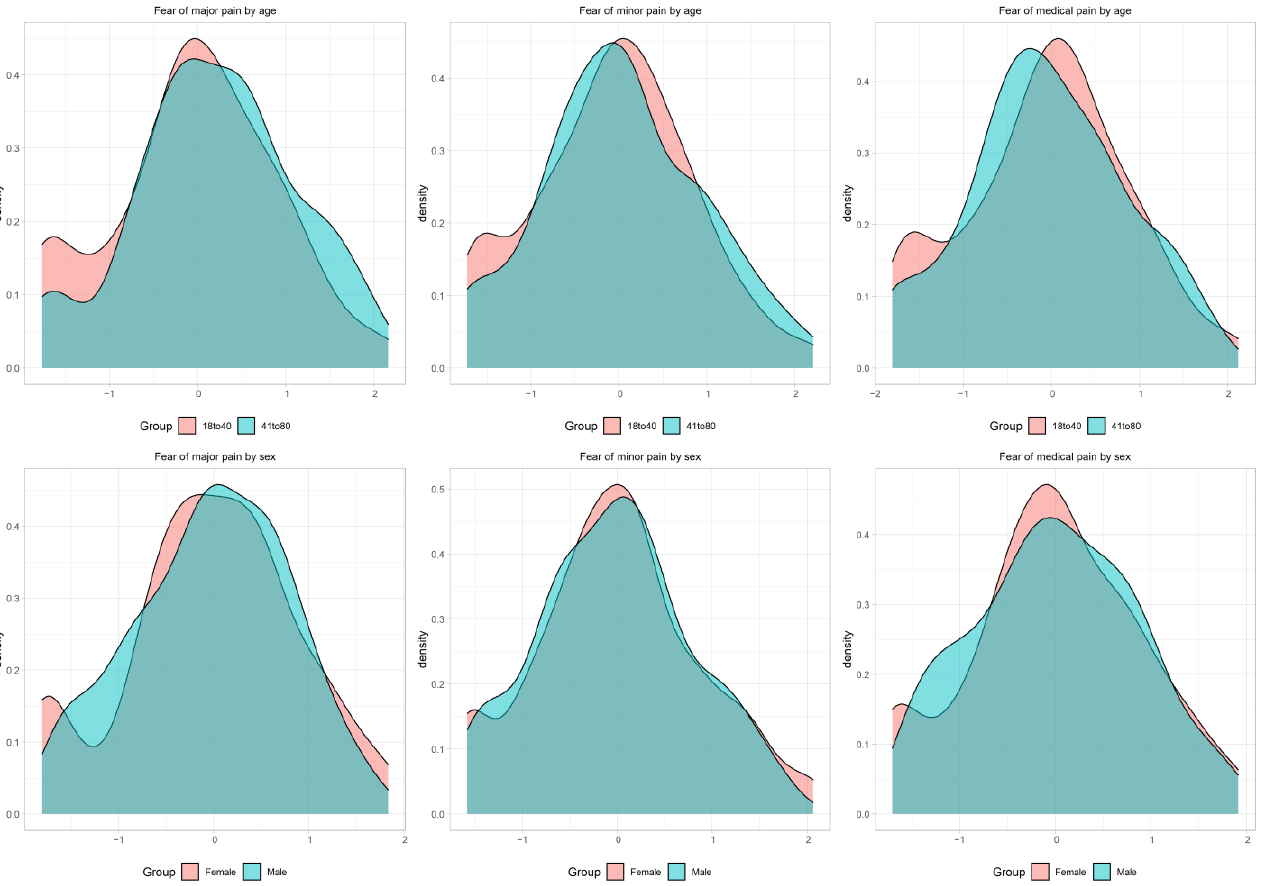
Figure 5. Latent scores density plots of fear of pain by age and sex. Note: The Kernel density plots indicate the distribution of factor scores according to age and sex. The x -axis denotes the factors scores, and the y -axis denotes the kernel estimates of the probability density.